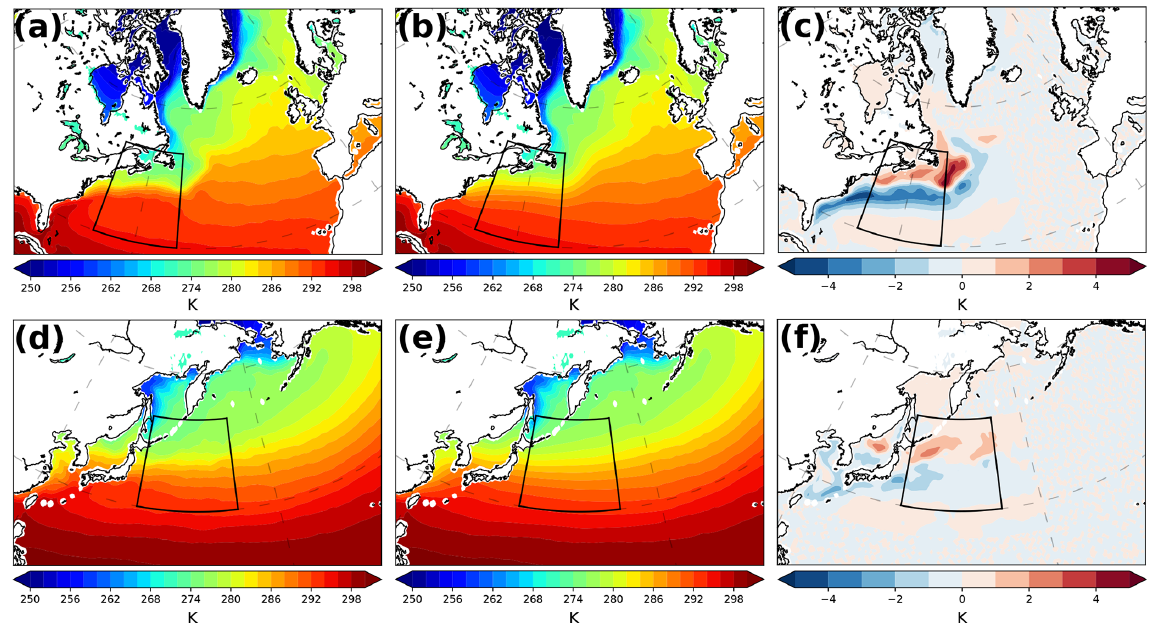
Figure 1. Climatological SST for DJF for (a) CNTL, (b) SMTHG, and (c) SMTHG–CNTL difference [K]. (d–f) As panels (a) – (c) but for the North Pacific. The Gulf Stream and Kuroshio regions are marked with a black box, respectively.